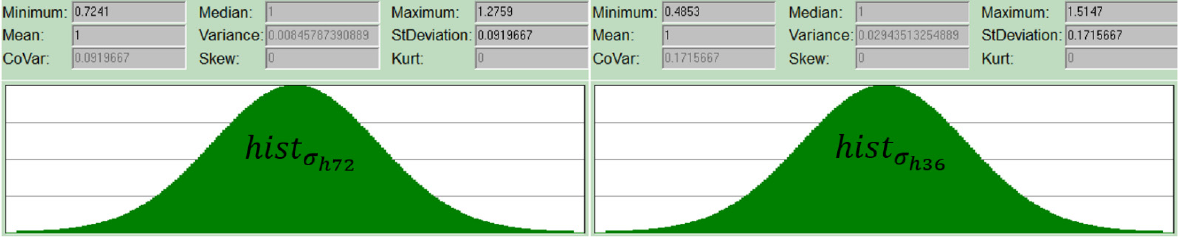
/1/ and ℎ𝑖𝑠𝑡 (cid:3097) /1/. (cid:3283)(cid:3123)(cid:3118) (cid:3283)(cid:3119)(cid:3122) /1/ and hist σ h 72 h 36